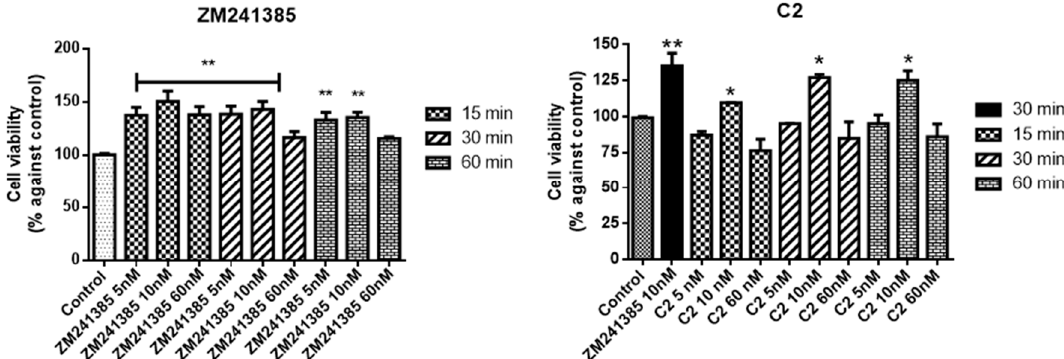
Figure 4. Effects of ZM241385 and C 2 on mixed glial cell culture viability. Percentage of cell viability after treatment with the ligand after 15, 30, or and 60 min of incubation. Results represent the